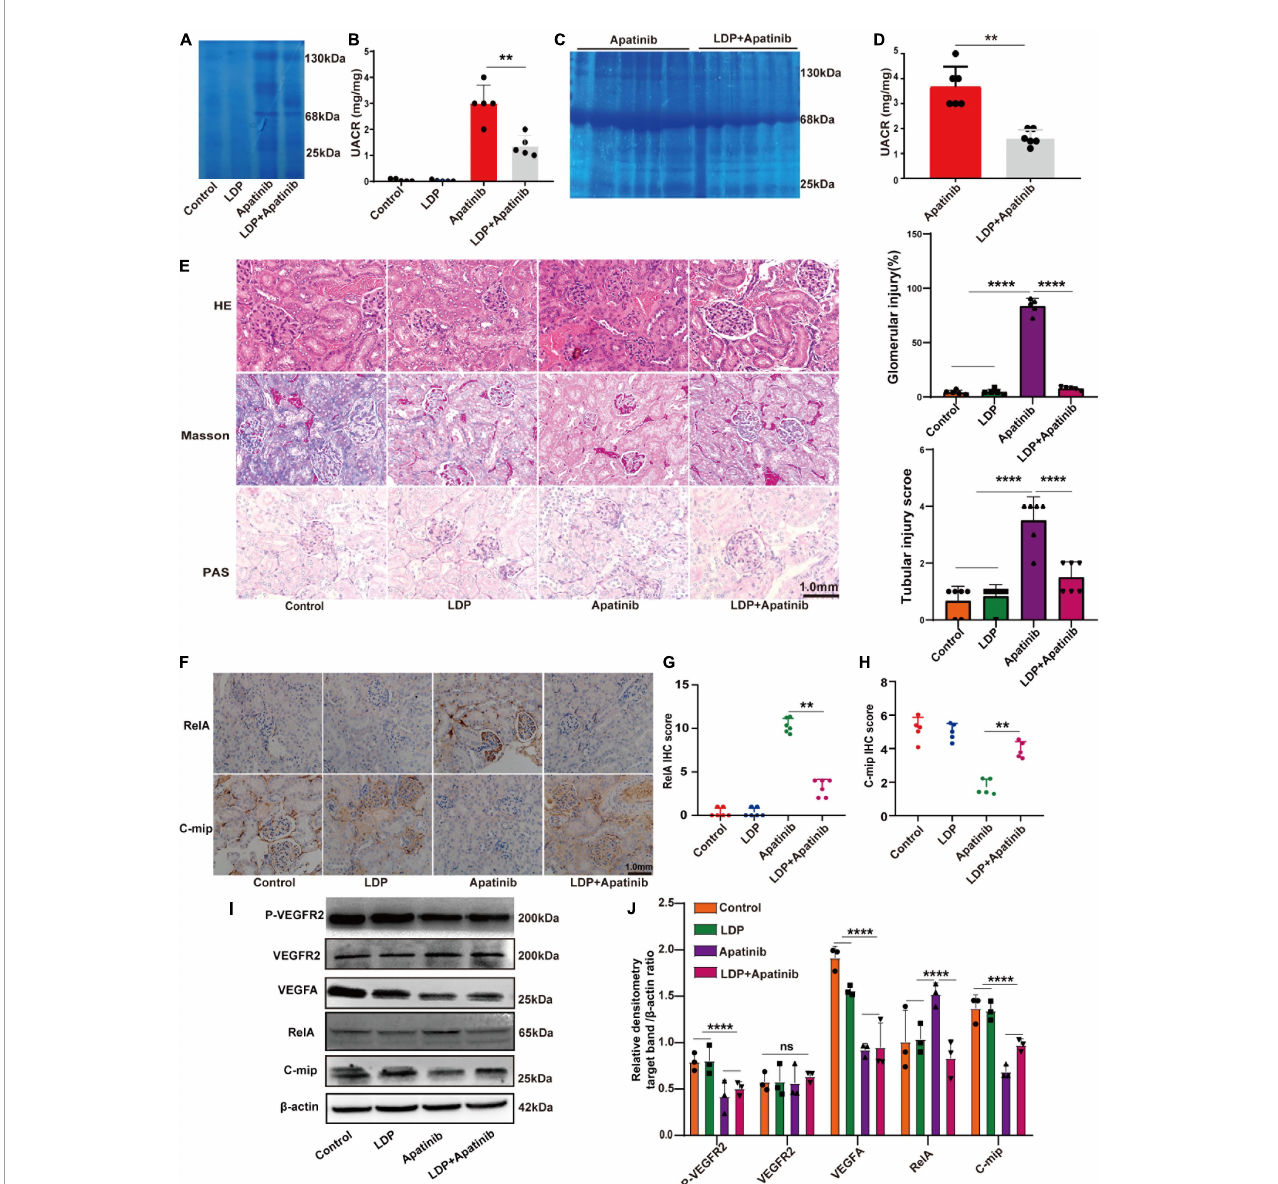
FIGURE3 LDP relieves TKIs-induced kidney damage by inhibiting the expression of RelA in kidneys. (A) Albuminuria (10 µ l urine in each lane) in male BALB/c nude mice treated with LDP, apatinib and LDP + apatinib in Coomassie gel ( n = 8). (C) Proteinuria (10 µ l urine in each lane) in male C57BL/6 mice treated with apatinib in Coomassie gel ( n = 8). Tubular injury, glomerular injury and severe kidney injury representatively proteins of mice were treated with LDP, apatinib and LDP + apatinib, or apatinib alone (25, 68, and 130 kDa). (B,D) Quantitative analysis of albumin/creatinine (UACR) in urine (8 mice in each group). (E) Typical HE staining, PAS staining and Masson staining of renal tissues and staining scores of Glomerular injury and Tubular injury in mice. (F–H) Representative images of immunohistochemistry and staining scores of RelA and c-mip in the kidney cortex tissues of mice ( n = 6 in each group). (I,J) Western blotting analysis of P-VEGFR2, VEGFR2, VEGFA, RelA and c-mip in mouse kidneys ( n = 3 samples per group), ** p < 0.01, **** P < 0.0001, ns represents no significant